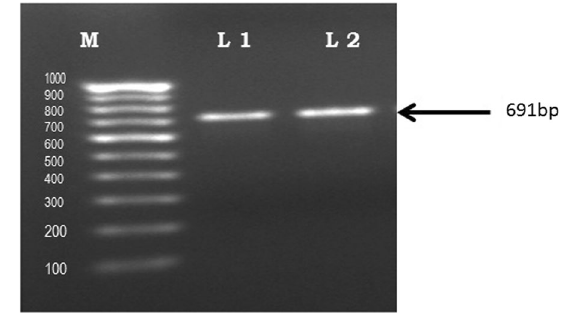
Fig. 4 polh gene of amplicon size 691 bp detected in PCR study; M marker (M): 100 bp ladder; Lane 1 = nucleopolyhedrosis virus (NPV) gene (replication1); Lane 2 obliqua polh NPV gene (replication